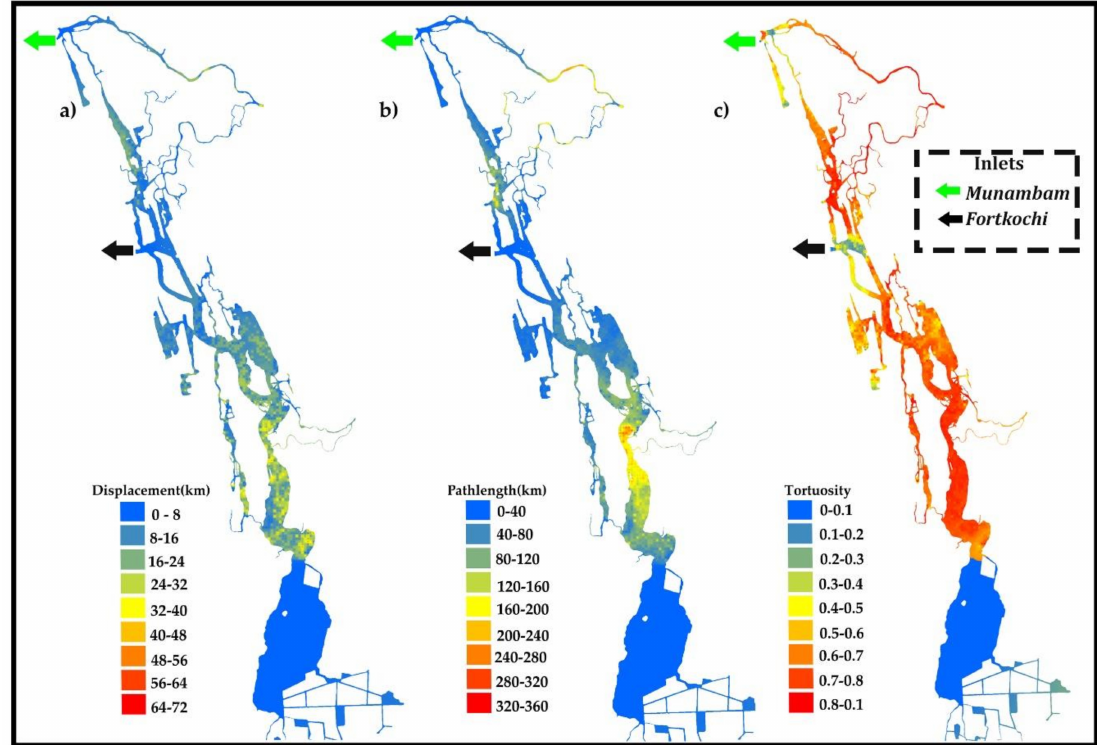
Figure 19. Displacement ( a ), path length ( b ) and tortuosity ( c ) of the CE during the control run simulation with Case 2 (river OFF and tide ON